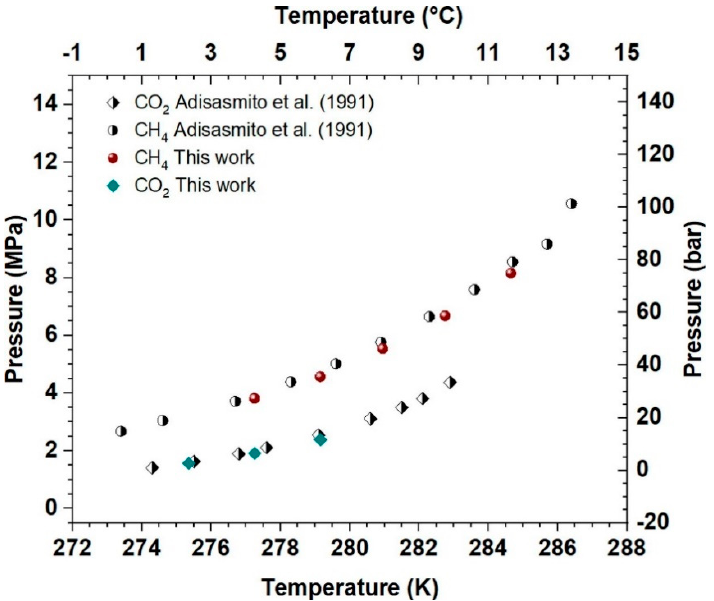
Figure 11. Phase diagram (equilibrium temperature as a function of pressure) for pure CO 2 and pure CH 4 gas hydrates [50]. Reprinted from Applied Energy, Vol 280/edition number 115,843, Quang-DuLe et al. Influence of the initial CH4-hydrate system properties on CO2 capture kinetics, Copyright (2020), with permission from Elsevier.